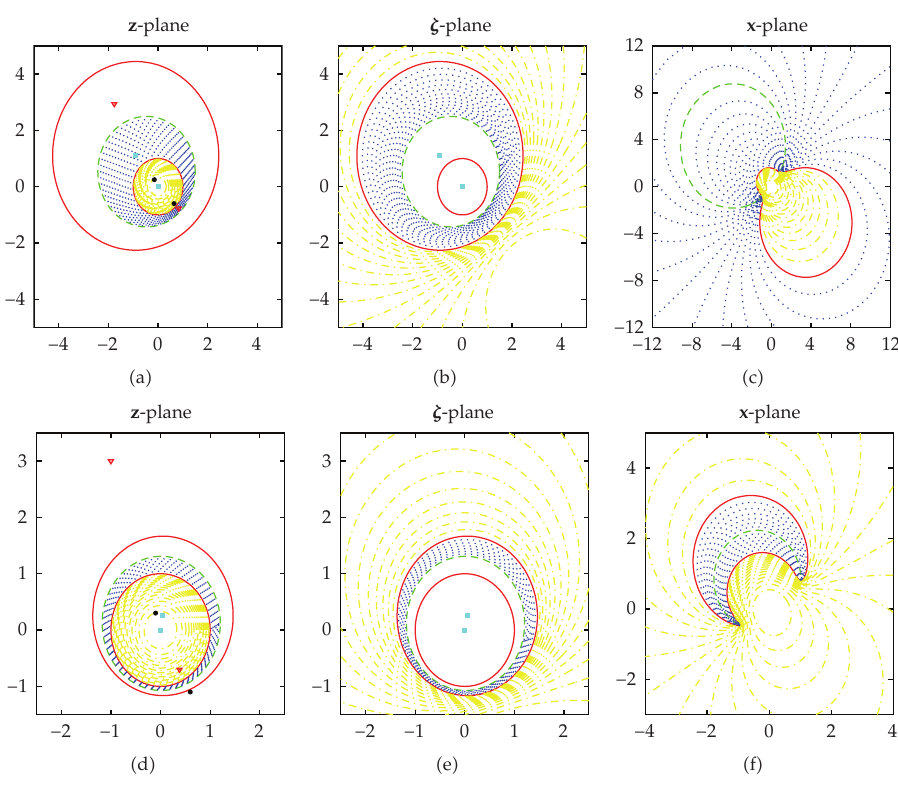
Figure 4: As in Figure 3, but for vortices of kind (cid:2) 2 , 1 (cid:3) (cid:2) first row, with a 1 (cid:7) 1, a 2 (cid:7) 0 . 8 − 0 . 2 i , z 1 (cid:7) 0 . 65 − 0 . 60 i , and z 2 (cid:7) − 0 . 15 (cid:6) 0 . 25 i (cid:3) and of kind (cid:2) 2 , 2 (cid:3) (cid:2) second row, with a 1 (cid:7) 1, a 2 (cid:7) 0 . 8 − 0 . 2 i , z 1 (cid:7) 0 . 6 − 1 . 1 i , and z 2 (cid:7) − 0 . 1 (cid:6) 0 . 3 i (cid:3)